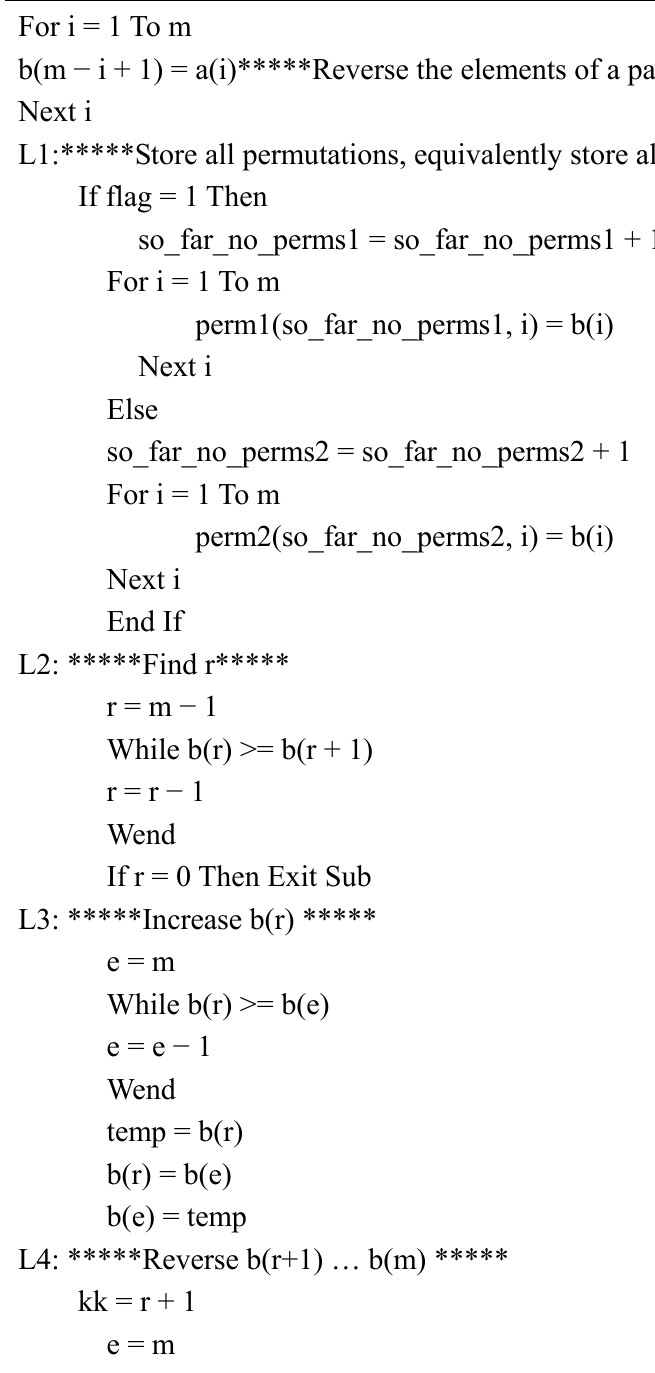
Algorithm 3. Sub Permute